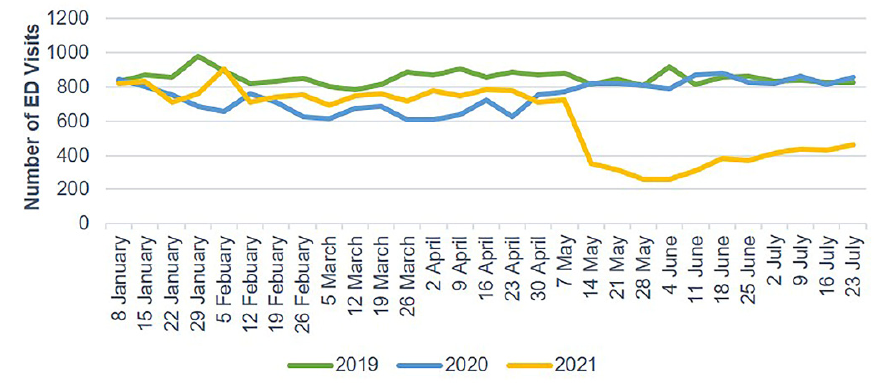
Figure 2. Weekly trauma-related ED visits from January to July 2019, 2020, and 2021. ED, emergency department.